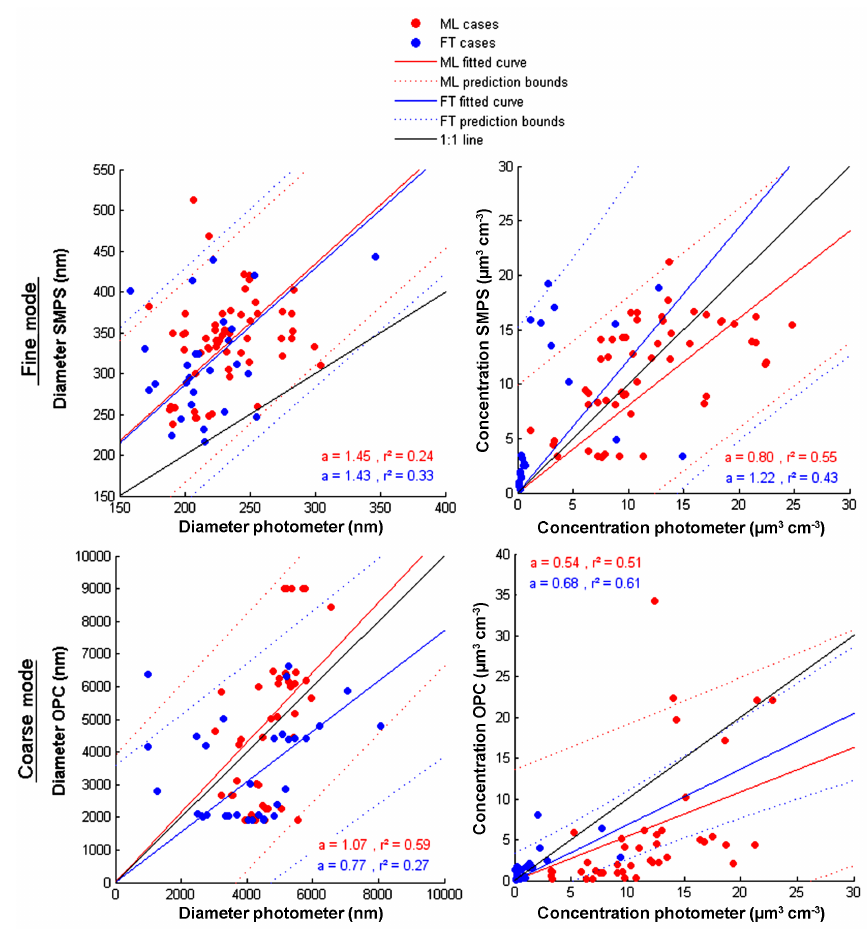
Figure 7. Scatter plot of fine and coarse mode modal diameters, and volume concentrations after applying the ML and FT contribution factors to sun photometer concentrations. Blue fit and markers are for FT data and red fit and markers for ML